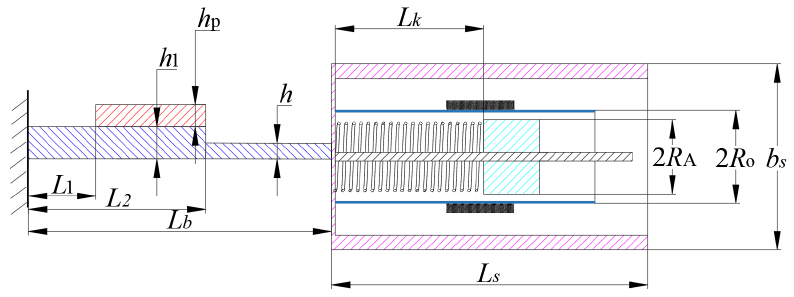
Figure 2. Cross-section diagram of GPEEH.